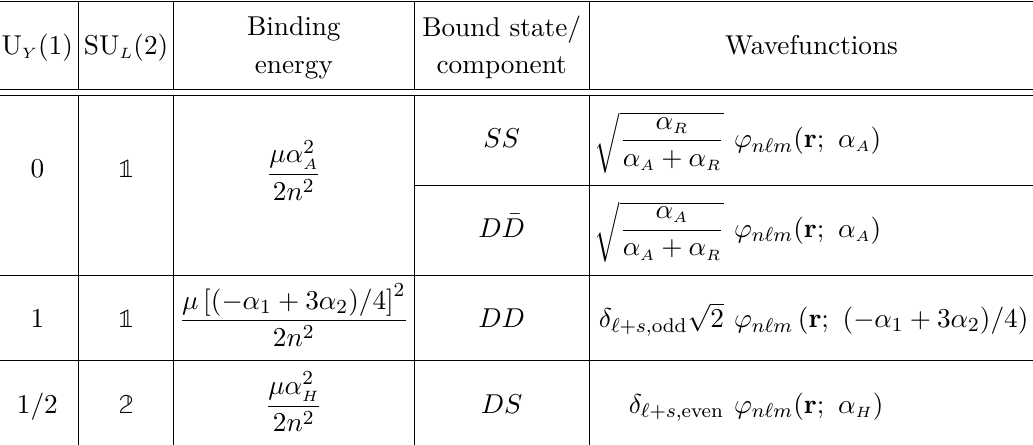
→ 0 . Here ϕ n‘m ( r ; α ) denotes H